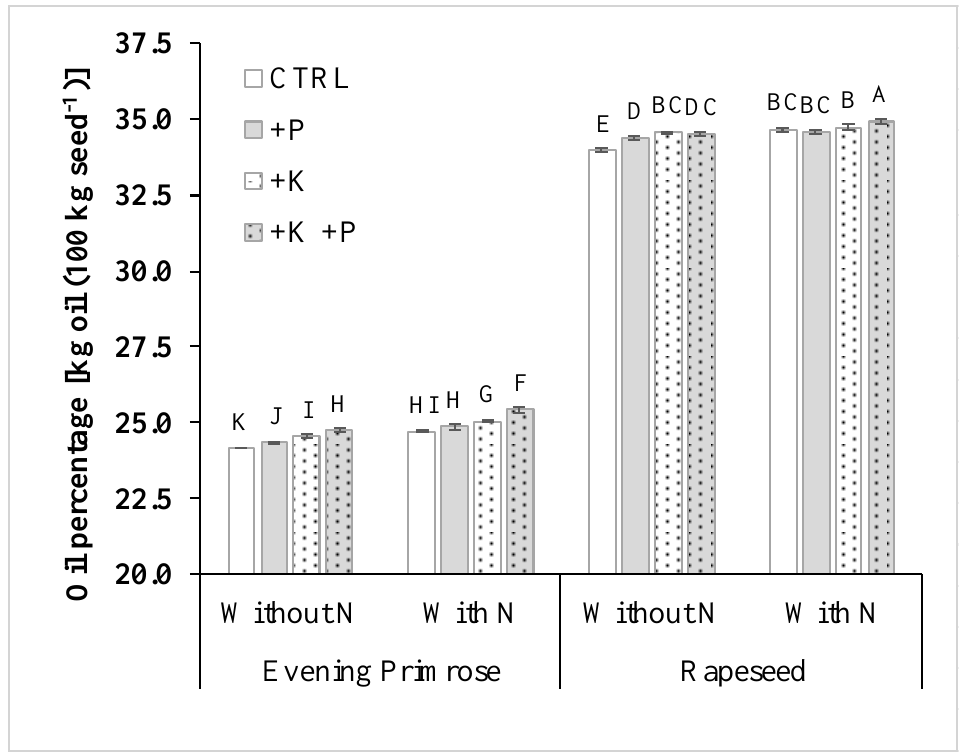
Figure 5. Least squares means (LSmeans) and standard error of the LSmeans of the oil concentration in the seed of Oenothera biennis L. local genotype (Evening Primrose) and Brassica napus L cv. serw 1 (Rapeseed) grown in 2 growing seasons in a P and K deficient soil and fertilized with 142.9 kg N ha −1 , 171.4 kg K 2 O ha −1 , or 36.9 kg P 2 O 5 ha −1 . Means with a letter in common cannot be considered different according to a conservative Tukey-grouping applied to the p differences of the LSmeans. N = 6. Please note that error bars are standard error estimates of the LSmeans and not the computed standard error, which can be found in Supplementary Materials Table S1. CTRL indicates a lack of P and K applications.